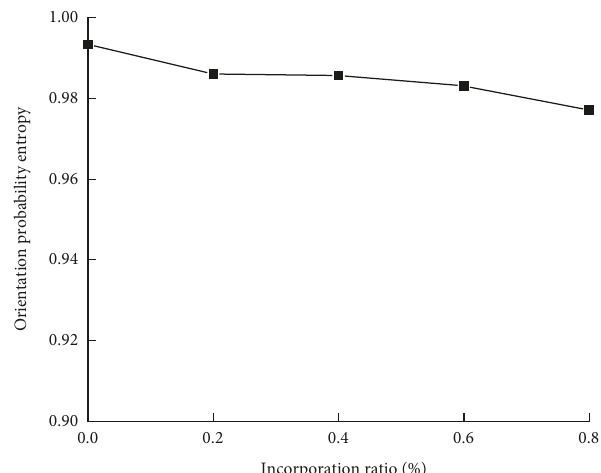
Figure 15: Fractal dimension of pore space versus ratio of glass